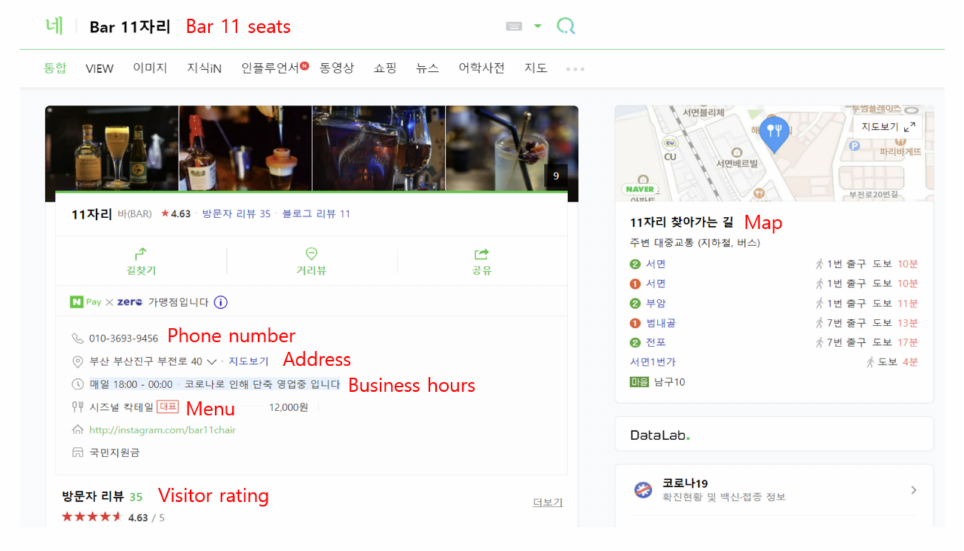
Figure 1. Busan wine bar online